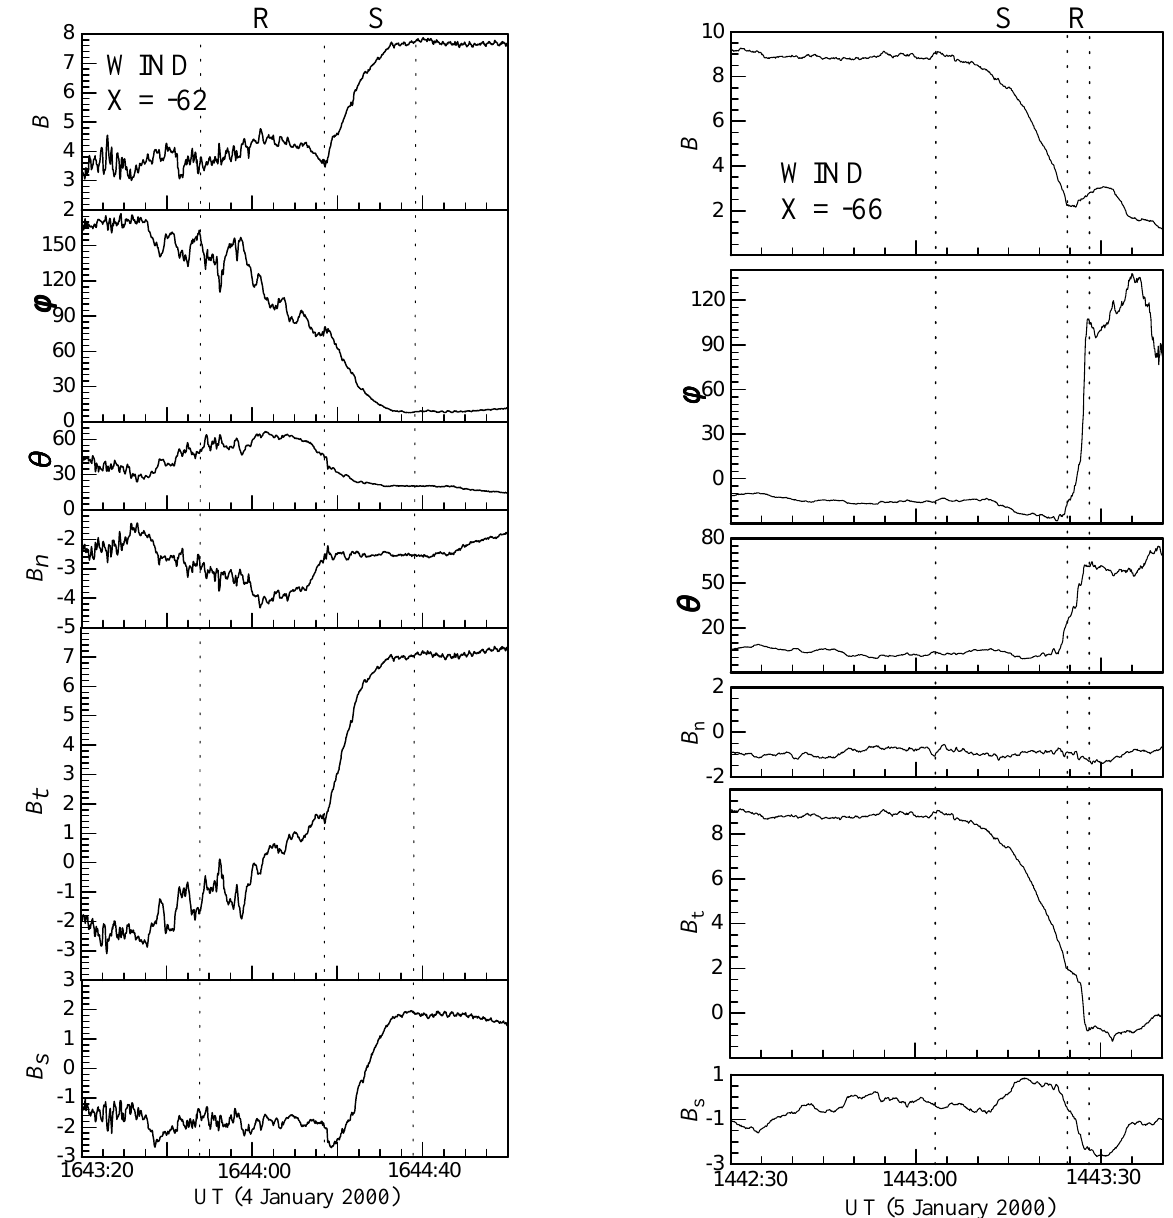
Figure 12 Fig. 13. More than a dozen slow shocks and double discontinuities Fig. 12. The double discontinuity of 4 January 2000 was observed were identified at the plasma sheet-lobe boundary during an 80-hour when the spacecraft crossed the boundary surface entering the south period on 2–5 January 2000. This figure shows the magnetic field lobe from the plasma sheet. structure of the 5 January double